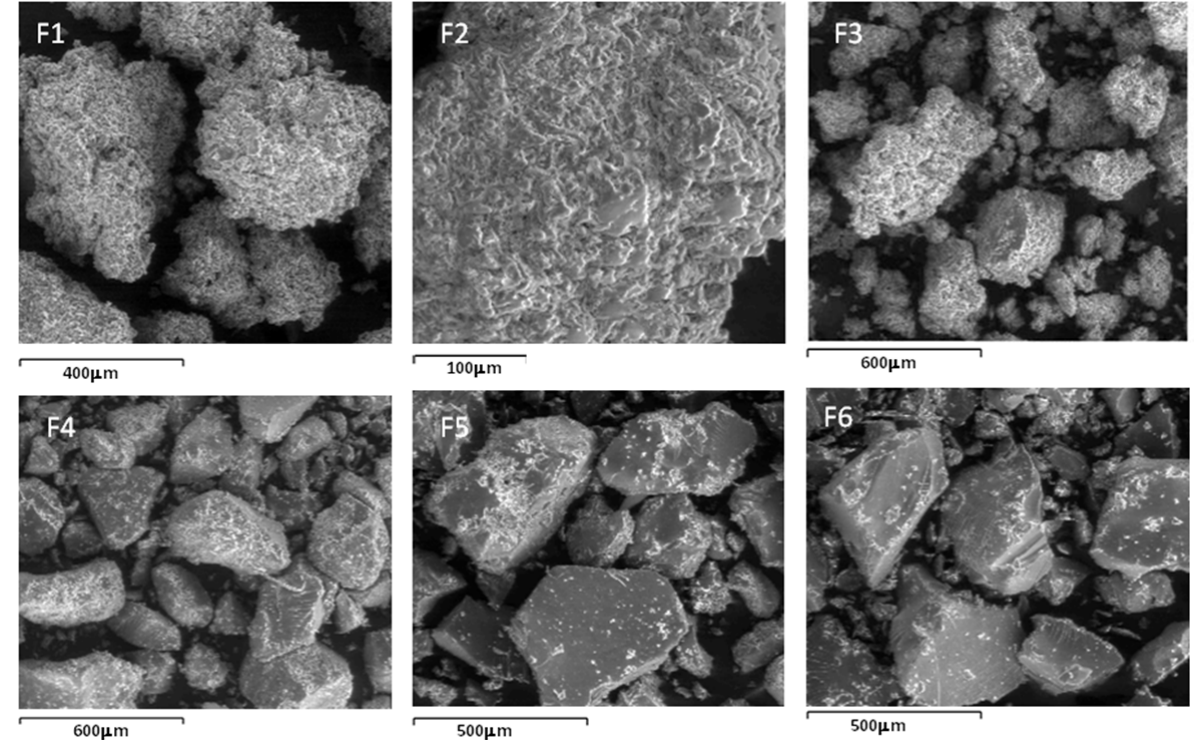
Figure 4. SEM images of conjugates F1 through